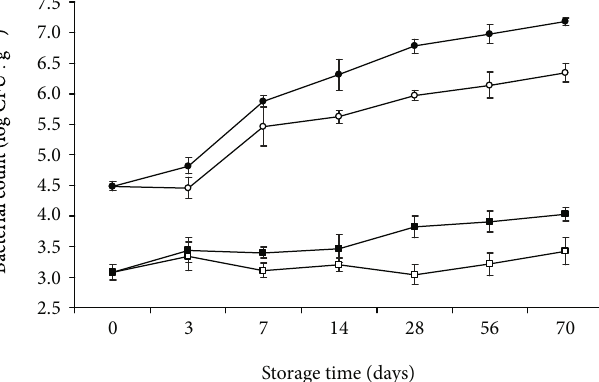
Figure 1: Total viable count (TVC) and lactic acid bacteria (LAB) in sausage snack stored in MAP (20% CO Description of symbols: white circles indicate TVC at 4 ° C; black circles indicate TVC at 20 ° C; white squares indicate LAB at 4 ° C; black squares indicate LAB at 20 ° C. Error bars indicate standard deviation.